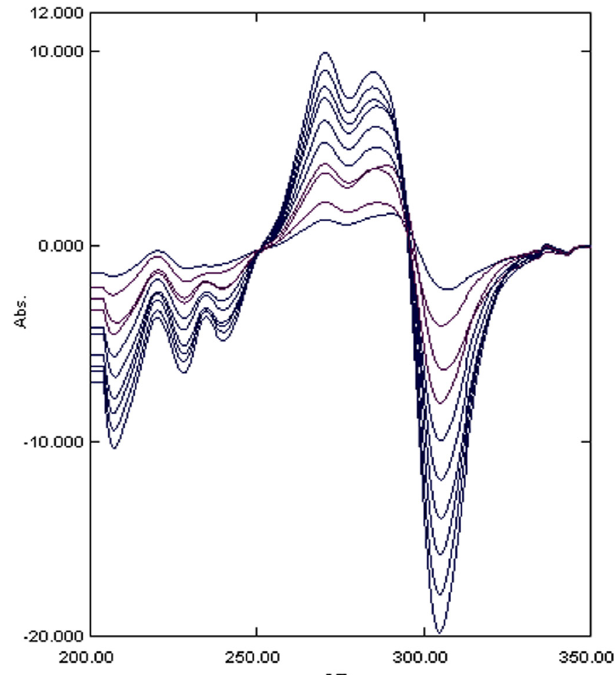
FIGURE 6 - Ratio derivative spectra of DS.